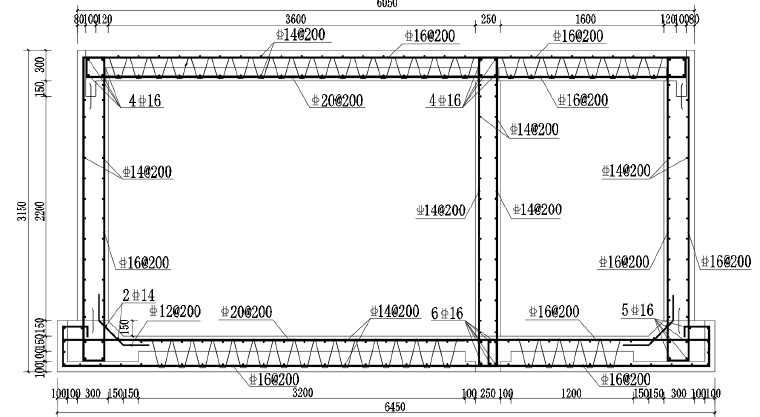
Figure 3. Reinforcement figure of full-scale tunnel model (Units: mm).